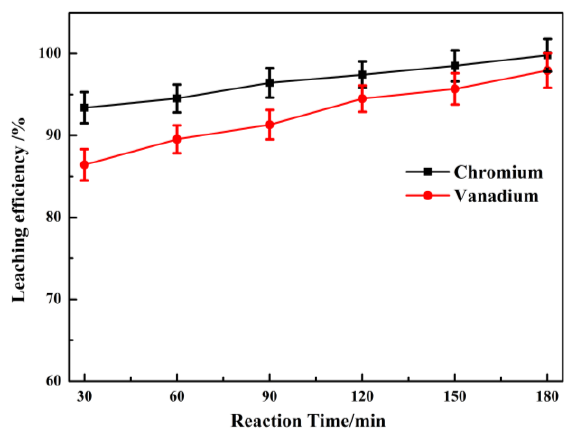
Figure 7. Effect of reaction time on the leaching efficiency of vanadium.